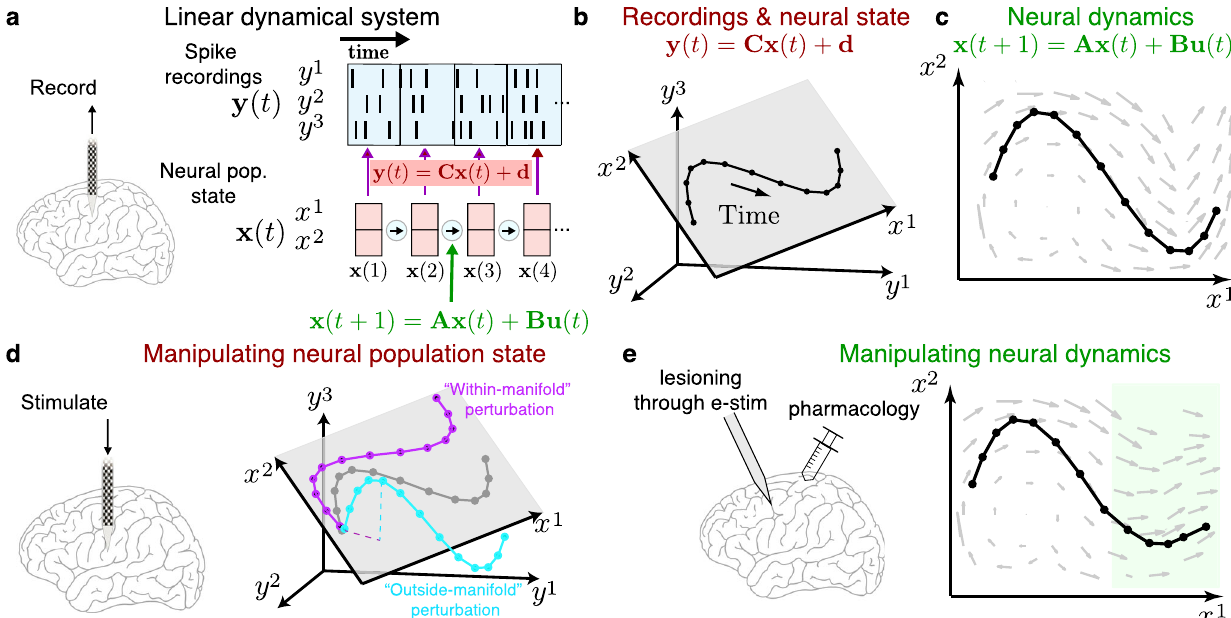
Fig. 1 Overview of neural dynamics and manipulations. a Linear dynamical system using neural recordings. Binned spiking activity, y (t), relates to a latent neural population state, x (t), that evolves according to linear dynamics, A , with inputs from other cortical areas, Bu (t). The neural population state is typically a low-dimensional trajectory, and the dynamics can be conceptualized as a fl ow fi eld. b In many cases, the neural state can be represented as a low-dimensional trajectory in a subspace of the higher-dimensional recordings. c In this subspace, the neural state evolves according to neural dynamics, which de fi ne a fl ow fi eld. In a LDS, the dynamics of A can be contractive, expansive, rotational, or a fi xed point. Inputs may cause the fl ow fi eld to exhibit more complex motifs, such as shown in this panel. Generally, dynamics and dimensionality reduction can also be modeled to be nonlinear. d By electrical or optogenetic stimulation, or applying perturbations to the sensory-behavior or force-behavior relationship, it is possible to make perturbations to the neural state, x (t). These perturbations can be “ within-manifold ” , which perturbs the neural state along its natural modes, or they can be “ outside-manifold, ” which perturbs the neural state along dimensions outside the plane spanned by x 1 and x 2 . e The neural dynamics ( fl ow fi eld, A ) can also be perturbed, for example by applying pharmacology or lesioning the circuit. The neural state changes as a result of the changing dynamics (highlighted in green). Panels a and b are modi fi ed by J. C. Kao and appeared in Pandarinath and colleagues 2018 38 inputs ( u (t)) from other brain areas and sensory pathways (Fig. 1c, neural dynamics). The neural population state and its dynamics are informative of behavior 3,4 .